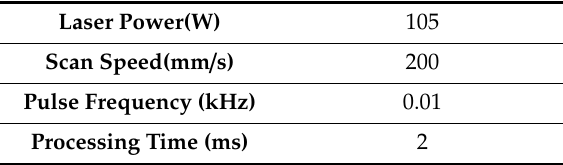
Table 1. Welding